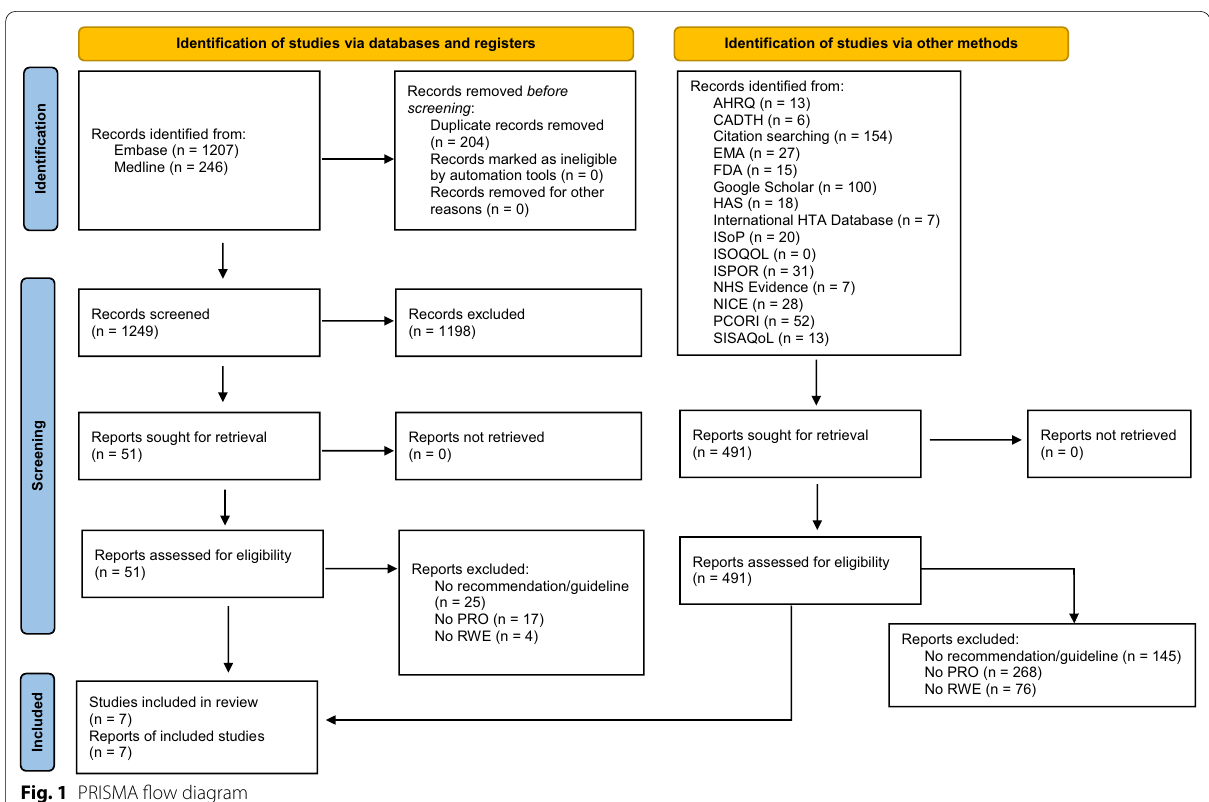
Fig. 1 PRISMA flow